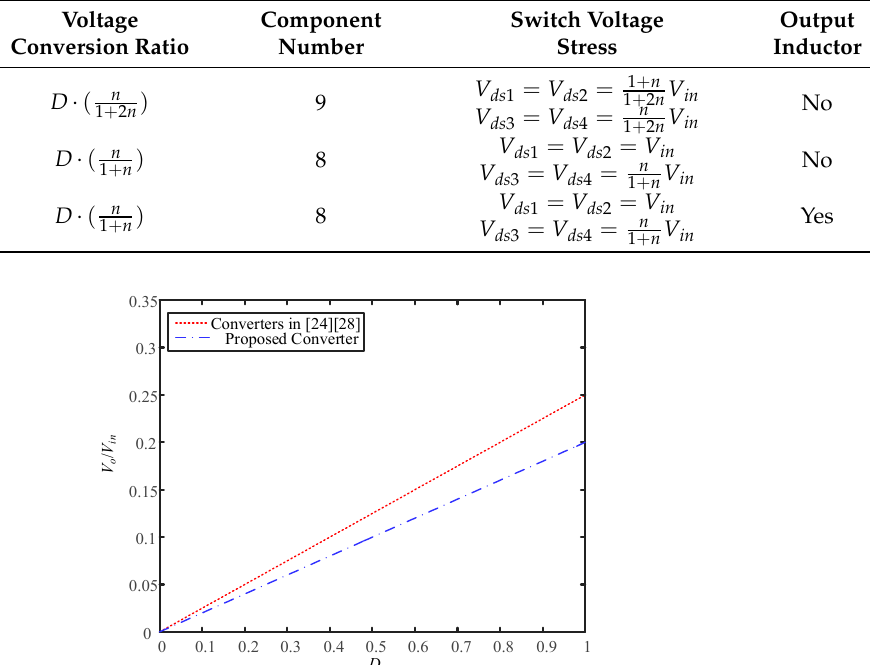
Figure 12. Voltage conversion curves of the circuit shown in Table 1 with n = 1/3.